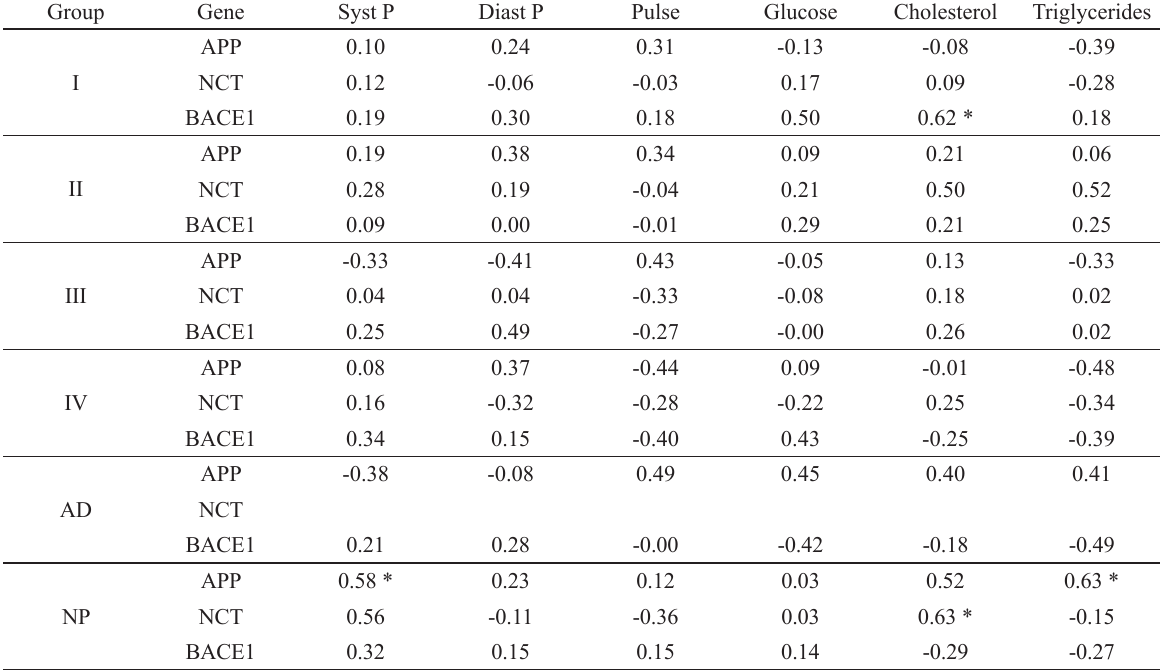
Correlation coefficients of APP, NCT and BACE1 against values of blood pressure, glucose, cholesterol and triglycerides per